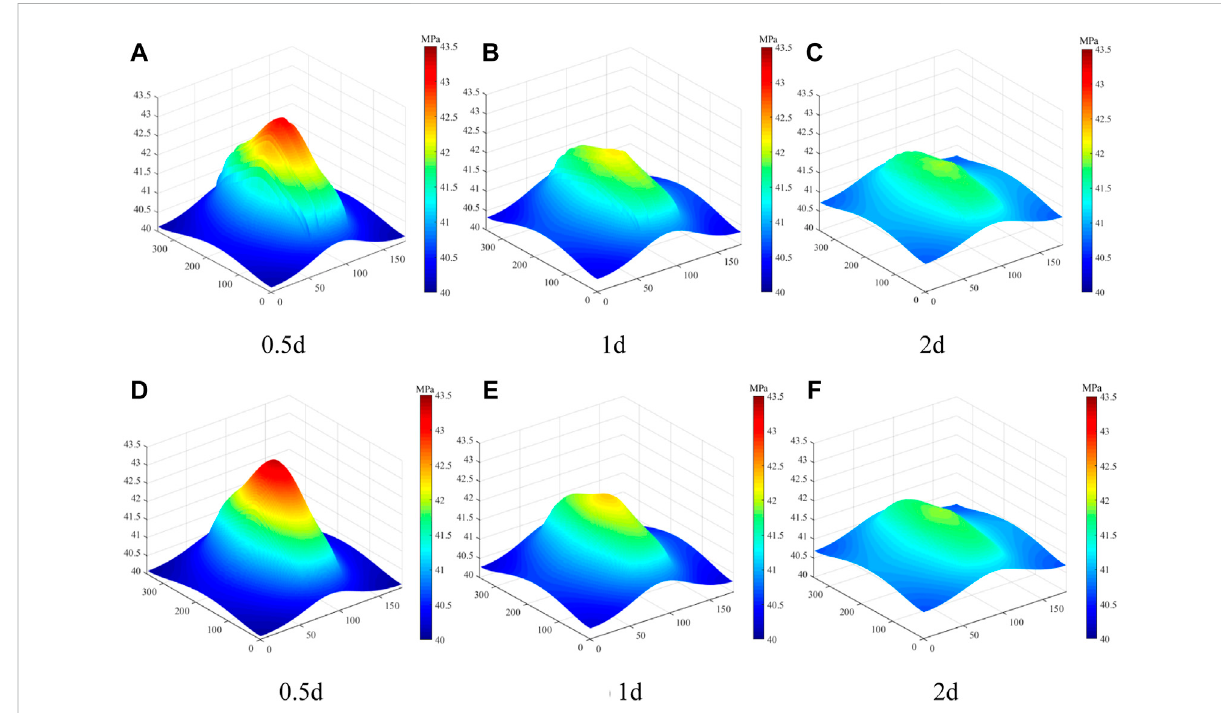
FIGURE 8 Distribution of pressure in micro-fracture system and matrix during shut-in period. (The range of pressure is from 40 to 43.5 MPa. The distribution of pressure in micro-fracture system is shown in (A – C) . The distribution of pressure in matrix is shown in (D – F)